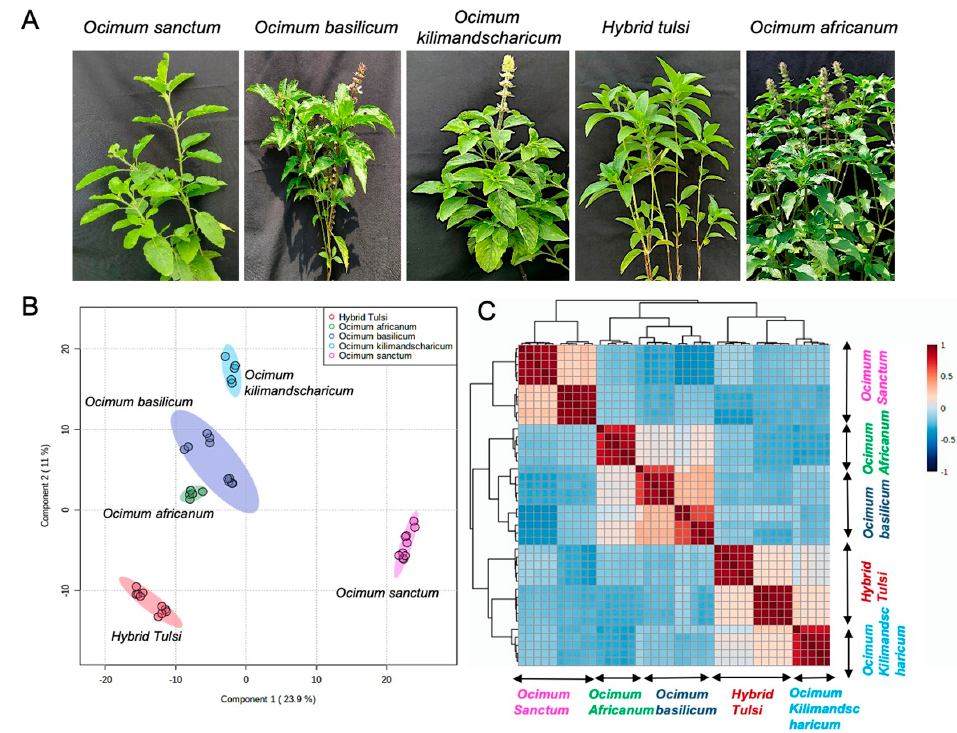
Figure 1. Differentiation of Ocimum samples from five different species according to their metabolite profiles. ( A ) Images of five different Ocimum species, namely, O. sanctum , O. basilicum , O. kilimandscharicum , Hybrid Tulsi, and O. africanum. ( B ) PLS-DA score plot for the first component (23.9%) vs. second component (11%), indicating discrimination between five different species of Ocimum samples acquired in LC-MS negative ionisation mode. ( C ) Pearson correlation of Ocimum samples from five different species.